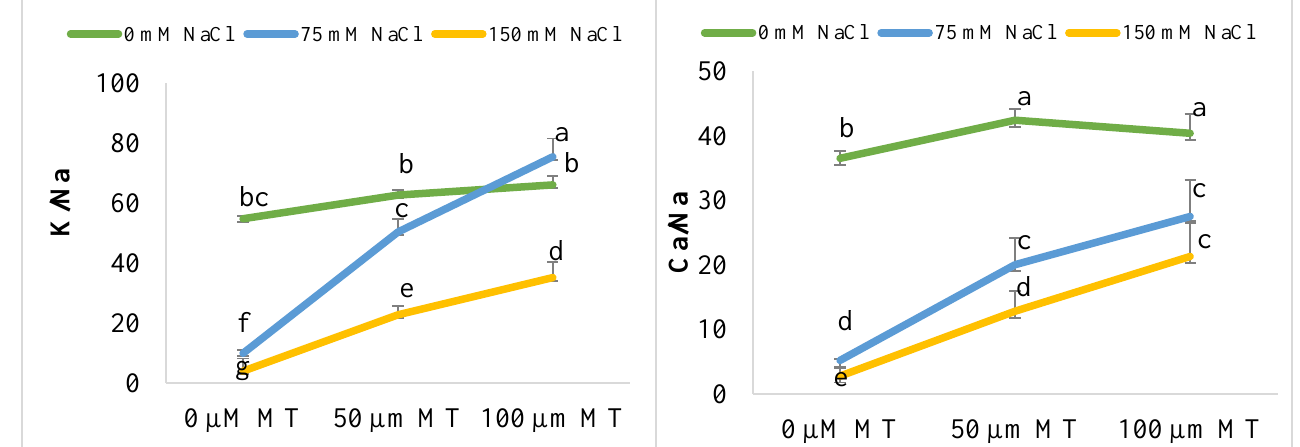
Figure 4. K/Na and Ca/Na ratio response in the leaves of the chickpea seedlings under salinity stress to MT applications.